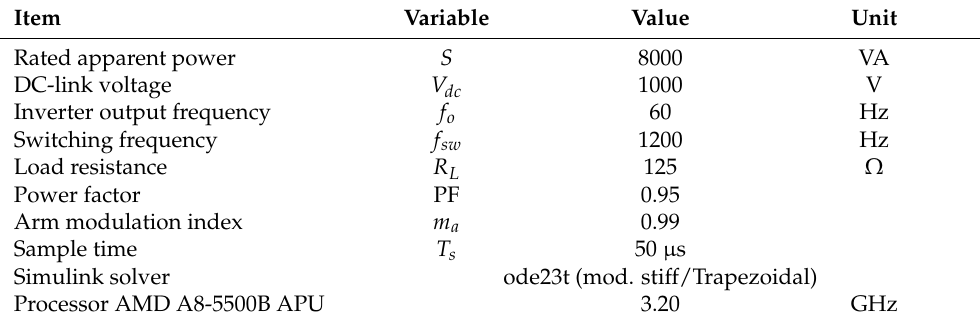
Table 2. Simulation parameters.